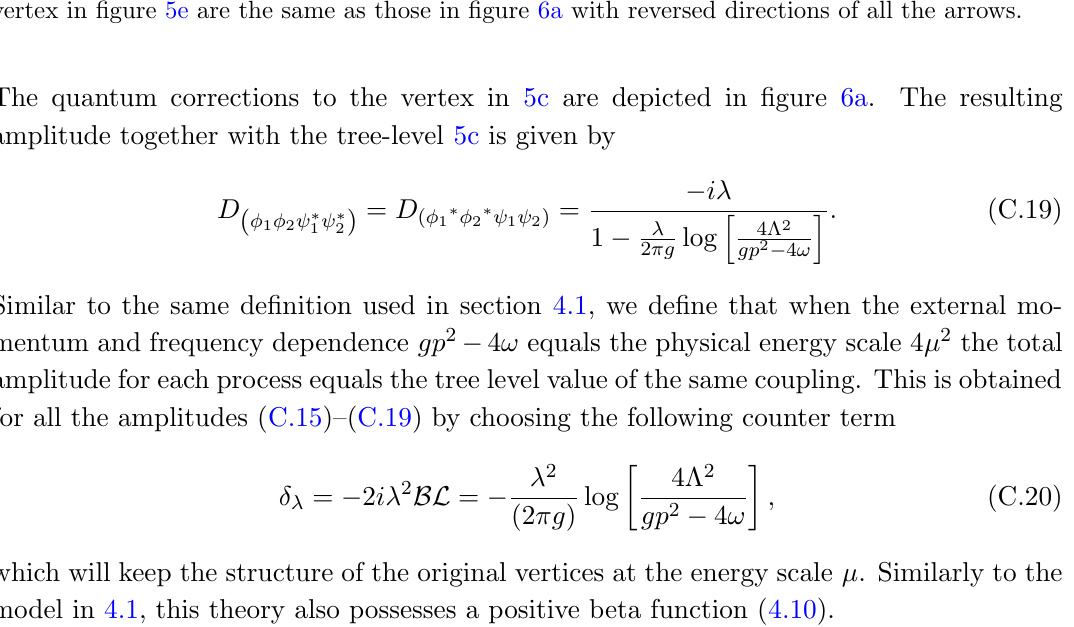
(c) Corrections to the vertex in (cid:12)gure 5b. Figure 6. Quantum corrections to the vertices in (cid:12)gure (4.8). Note that the corrections to the vertex in (cid:12)gure 5e are the same as those in (cid:12)gure 6a with reversed directions of all the